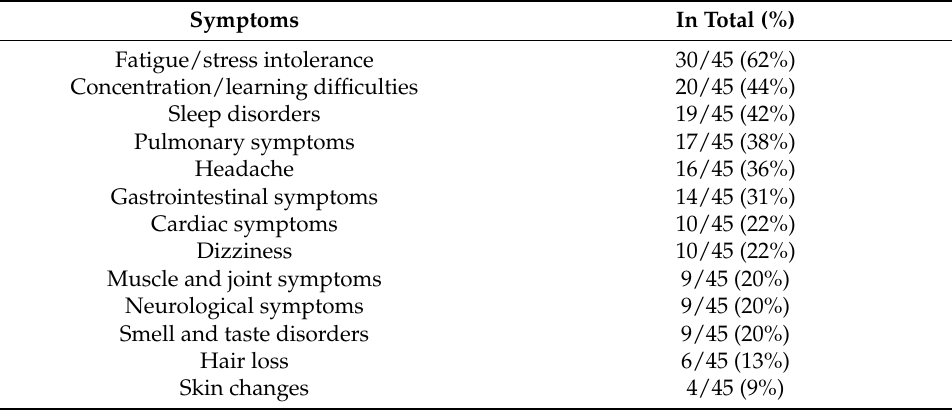
Table 2. Predominant symptoms at the initial presentation.